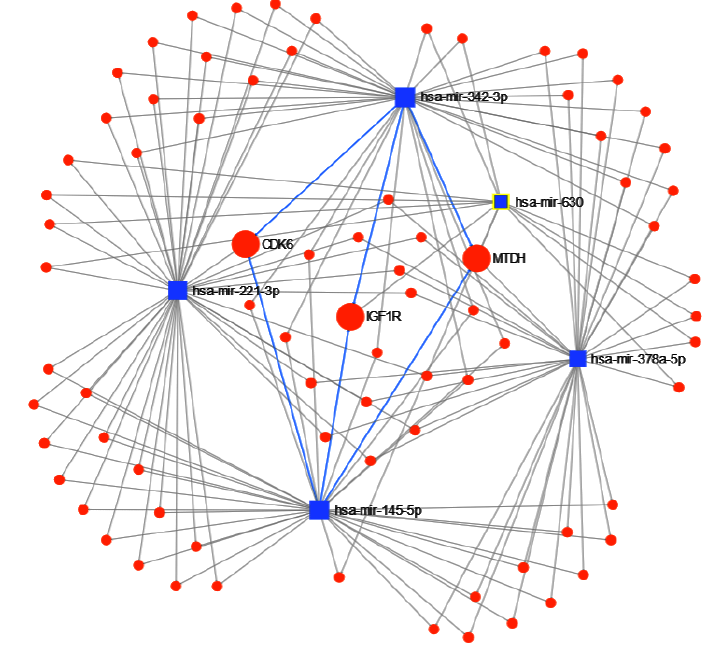
Figure 13. miRNET targeted genes analysis, showing genes targeted by at least 3 of the 5 miRNAs to separate Triple Negative Breast Cancer (TNBC) from other breast cancer subtypes: metastasis gene metadherin-positive (MTDH), type 1 insulin-like growth factor receptor-positive (IGF1R) and cyclin-dependent kinase 6-positive (CDK6). Table 9. Top 10 miRNet enrichment analysis results for miRNAs hsa-miR-378*, hsa-miR-221,